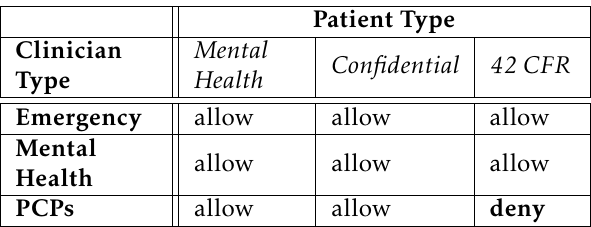
Figure 6. Sample access control matrix based on patient and